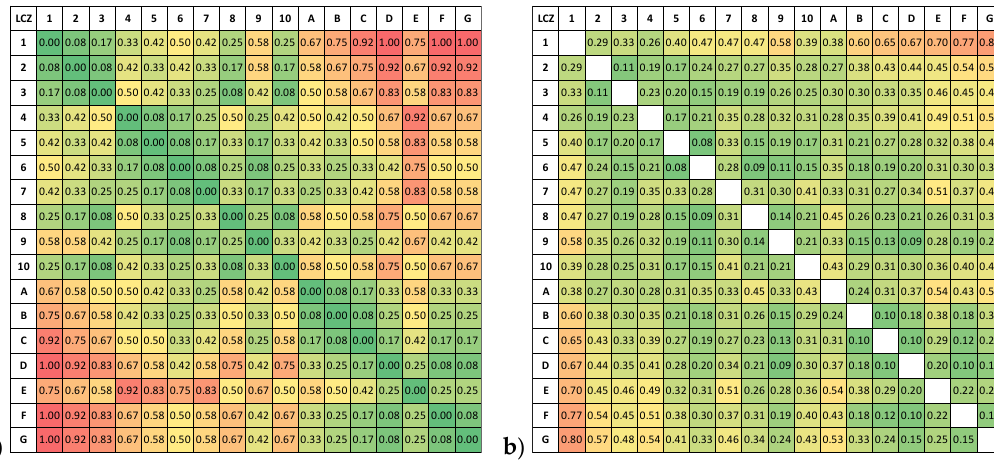
Figure 5. ( a ) Class dissimilarity after ( a ) Bechtel et al. (B17) and ( b ) Johnson and Jozdani (JJ19).